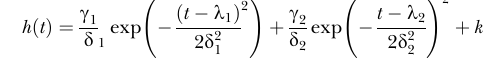
Figure S6. Fits to the Time Course Data II: Experiment